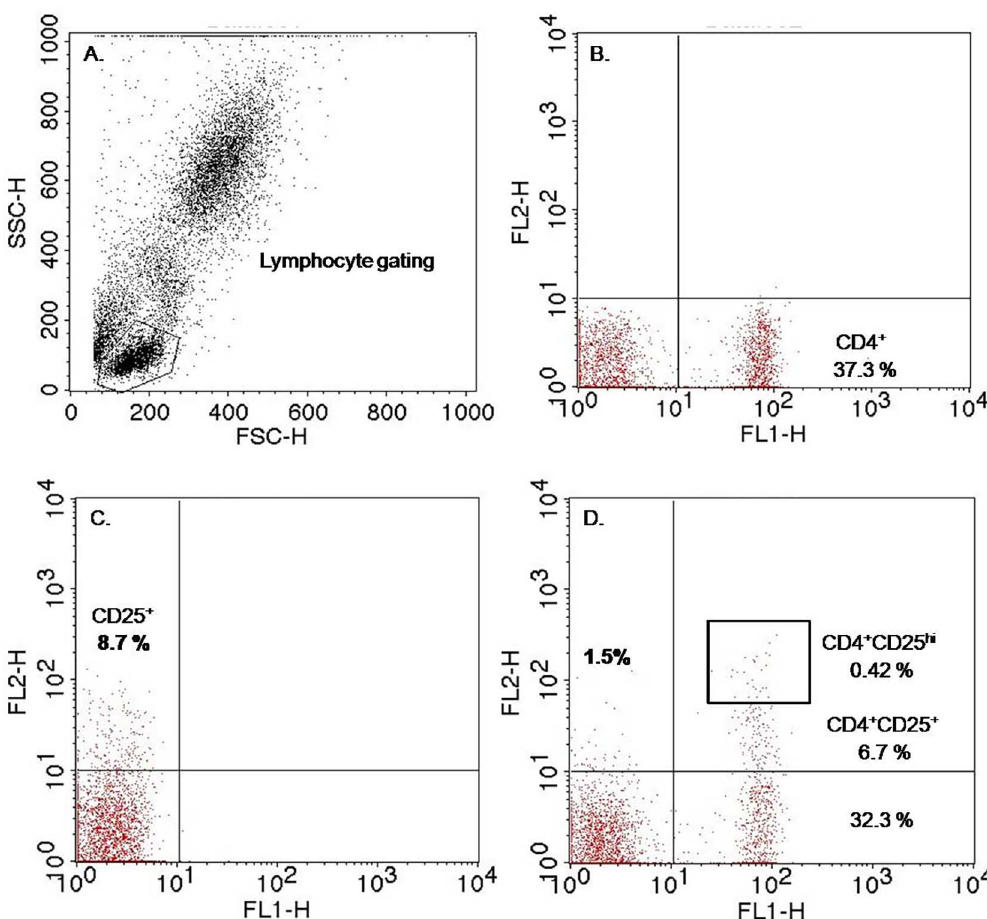
Fig 1. Gating strategyof regulatory T Cells (CD4 cells expressingHigh CD25 Marker,CD4+CD25 hi ). CD4+ CD25 hi cells were characterized by flow cytometry. Fig 1A represents a dot plot showinglymphocyte gating from the PBMC populationbasedon forward and side scatter. Lymphocytes were analyzedby flow cytometry for CD4 and CD25 expressionafter stainingwith anti-humanCD4-FITC and anti-humanCD25-PE. The CD4+ T cells expressing the highestlevel of CD25+ are considered as T regulatory(Tregs) cells. % of Tregs frequencies (CD4+CD25 hi ) were calculatedfrom total lymphocyte gated. Numbers in each quadrantrepresent the percentages of that cell type calculatedfrom total lymphocyte gated. Lower right quadrantof Fig 1B representsCD4+cells,Upper left quadrantof Fig 1C- represents CD25+cells, Upper right quadrant of Fig 1D represents CD4 + CD25+ cells and Box represent CD4 cells expressinghigh levels of CD25